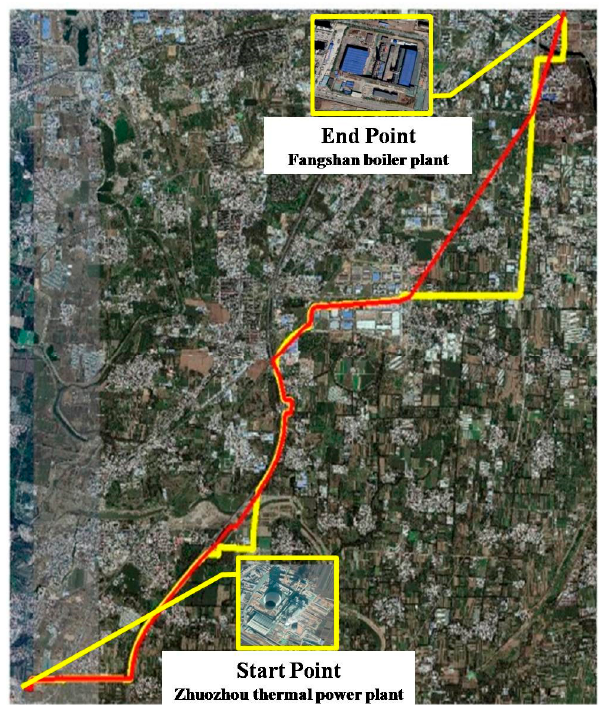
Figure 20. The best route of the HACCS.